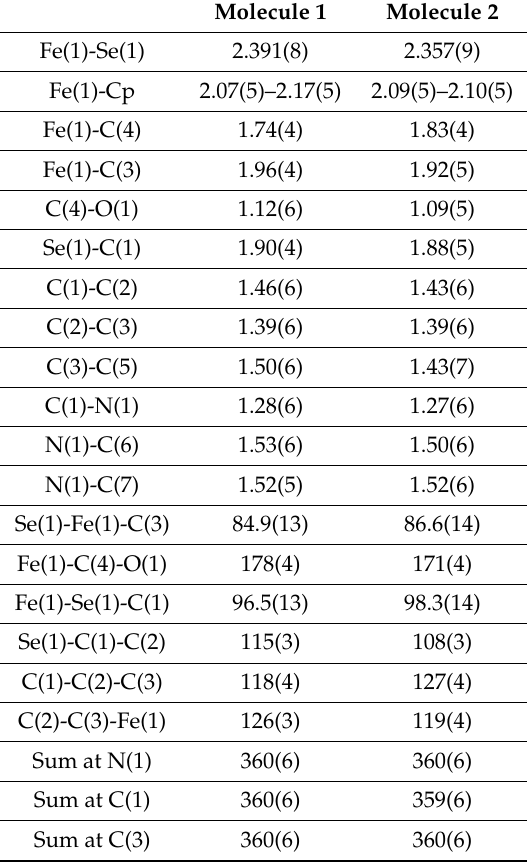
Figure 3. Molecular structure of [FeCp(CO){SeC 1 (NMe 2 )C 2 HC 3 (Me)}], 3 . Displacement ellipsoids are at the 30% probability level. Table 1. Selected bond lengths (Å ) and angles (°) for 3 .